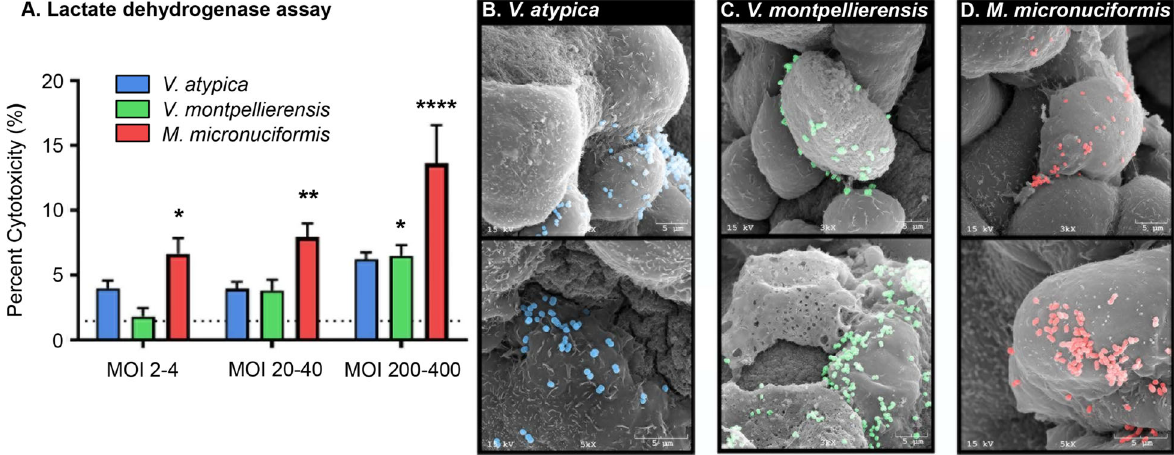
Fig. 1 M. micronuciformis and V. montpellierensis induces signi fi cant cytotoxicity in 2-D cervical cell monolayers compared to V. atypica . A LDH assay to quantify cytotoxicity in cervical epithelial monolayers. M. micronuciformis infections induced signi fi cant cytotoxicity to cervical epithelial monolayers at a range of MOIs from 2 to 400. V. montpellierensis infections induced signi fi cant cytotoxicity at the highest MOI only. Error bars designate standard deviation. Statistical differences were tested using one-way ANOVA with Dunnett ’ s adjustment for multiple comparisons, * P < 0.05, ** P < 0.005 **** P < 0.0001. Scanning electron microscopy (SEM) images of B V. atypica , C V. montpellierensis , and D M. micronuciformis colonizing 3-D cervical epithelial cells. SEM images were pseudo-colored using Photoshop 19.0 CC